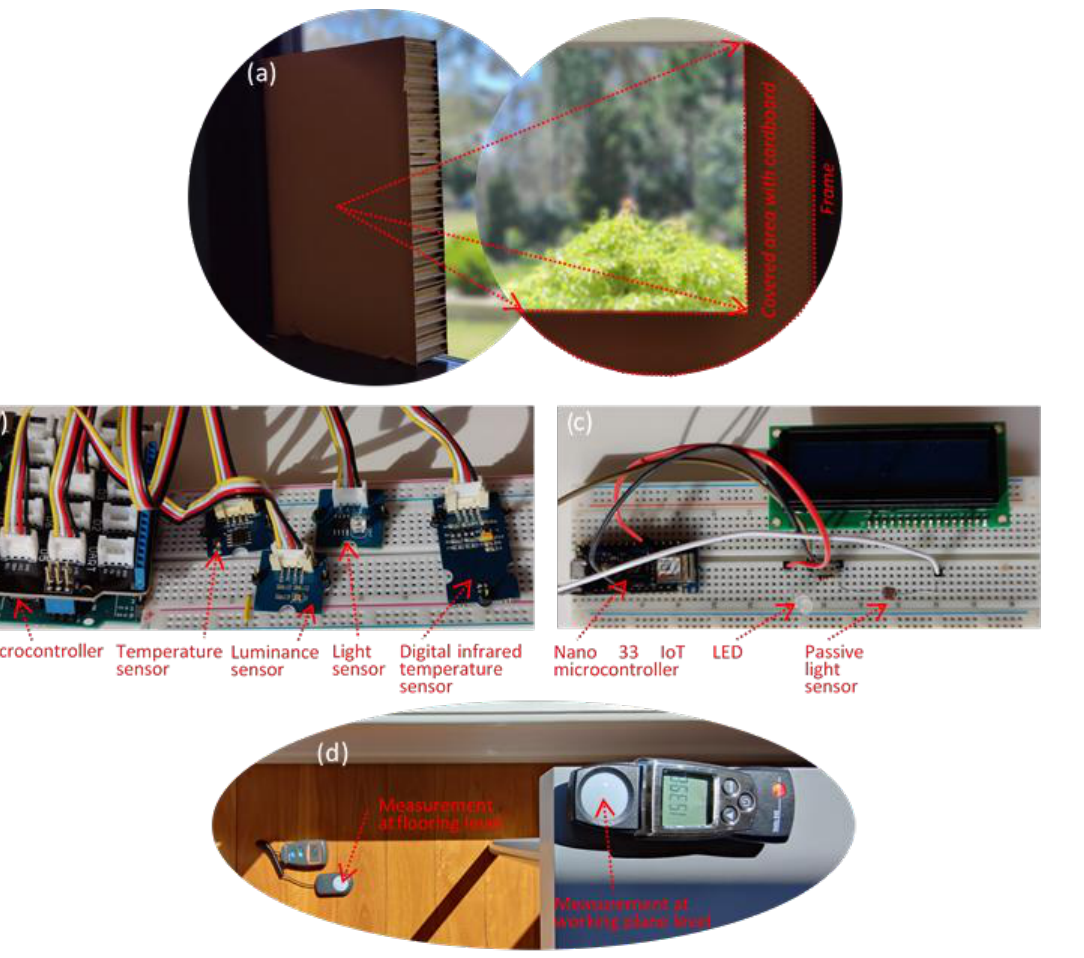
Figure 2. Validating experiment: ( a ) partly blocking transparent area validating daylight simulation; ( b ) a module for sensing and recording data; ( c ) an automatic responsive module switching light and air-conditioner in response to comfort metrics threshold; and ( d ) field daylight measurement.